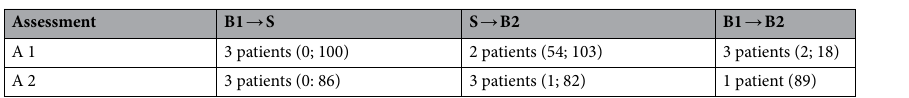
Table 1. Number of patients with significant changes in age-corrected average clustering coefficient of evolving functional brain networks ( p < 0.05) between periods (B1, S, B2) of the experimental schedule (range of Wilcoxon signed rank test W values in brackets).